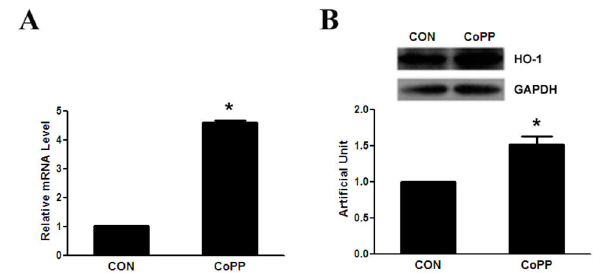
Figure 2. CoPP upregulates HO-1 gene expression in mouse primary hepatocytes. Primary hepatocytes are treated for 16 h with and without 10µM of CoPP, after which cells are harvested, total RNA and protein assays are carried out. (A) HO-1 mRNA is quantified by qRT-polymerase chain reaction and relative amounts of HO-1 mRNA are normalized to β-actin mRNA. (B) Protein levels are quantified by western blot as described in Methods and relative amounts of HO-1 protein are normalized to GAPDH. *p < 0.05.